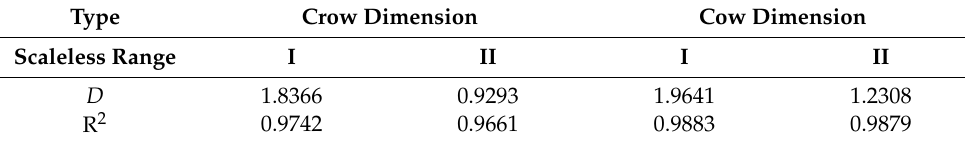
Table 4. The determining data of correlation dimension of the Fuzhou park system.